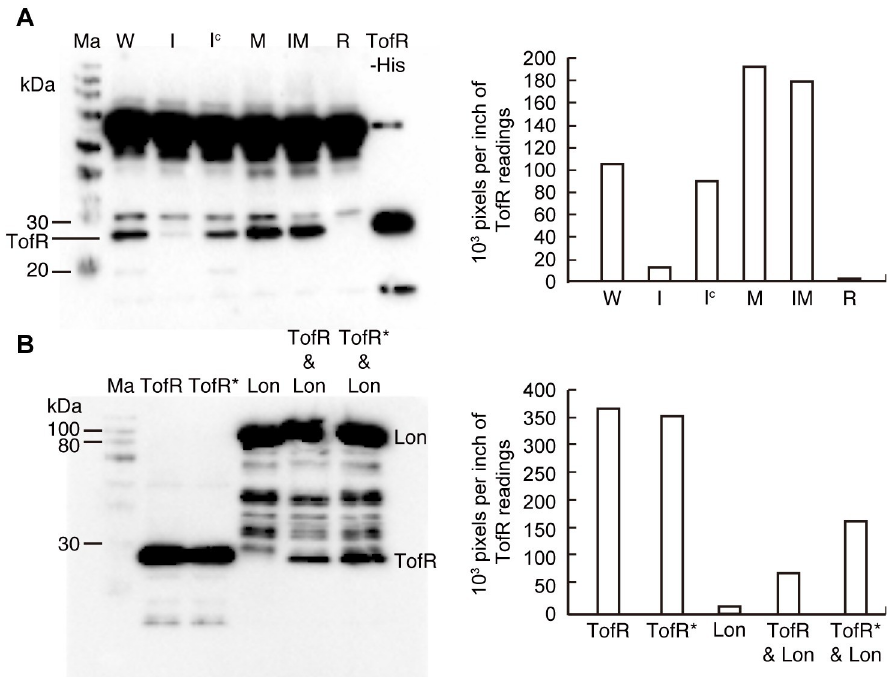
Fig 6. Lon protease affects the level of TofR. (A) TofR protein was detected in the B . glumae strains grown in the early stationary phase via western blot analysis using an anti-TofR antibody. Ma, W, I, I c , M, IM, R, and TofR-His denote the molecular marker, the wild type, tofI mutant, chemically complemented strain of tofI mutant with addition of 1 μ M C8-HSL, lon mutant, tofI / lon double mutant, tofR mutant, and TofR-His overexpressed in BL21(DE3), respectively. The densities (pixels/inch) of the TofR bands are presented alongside the blot. (B) Western blot analysis using an anti-His antibody showed that Lon influences the levels of TofR, and this influence depends on the presence of C8-HSL. The TofR-His, His-Lon-His, and TofR-His plus His-Lon-His were overexpressed in the BL21(DE3) via addition of 1 mM IPTG with or without 4 μ M C8-HSL. The symbols � and & denote addition of 4 μ M C8-HSL and co- expression of two proteins, respectively. The densities (pixels/ inch) of TofR bands are shown alongside the blot.